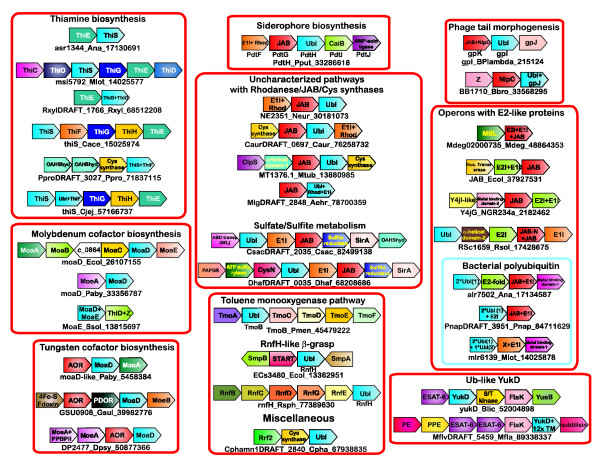
Gene neighborhoods of prokaryotic ThiS/MoaD-like ubiquitin domains and functionally associated proteins. Genes found in conserved neighborhoods are depicted as boxed arrows with the arrow head pointing from the 5' to the 3' direction. ThiS/MoaD-like proteins are shaded in blue. Other than in the classical ThiS and MoaD pathways, ThiS/MoaD/Ubiquitin-like proteins are labeled Ubl for ubquitin-like domain. The ThiS/MoaD-like proteins in each operon are identified in black lettering below the neighborhood by gene name, species abbreviation and gi number, demarcated by underscores. In the instances where ThiS/MoaD-like domains are absent, the gene neighborhoods are identified by the JAB domain containing protein. Alternative names of experimentally well characterized genes are shown below the boxed arrows for that gene. Boxed arrows with no colors represent poorly conserved proteins. Conserved neighborhoods are clustered according to major assemblages of gene neighborhood as described in the text. In Sulfolobus MoaD and MoaE are intriguingly linked to ThiD, but any possible role in thiamine biosynthesis remains unclear. Species abbreviations are listed in the legend to Figure 2. AOR, aldehyde ferredoxin oxidoreductase; Cys Synthase, cysteine synthase; PE, PE family of proteins; PPE, PPE family of proteins;Rhod, Rhodanese domain; Z, poorly characterized protein with an α + β domain with several conserved charged residues; X, β-strand rich globular domain; YueB, bacillus YueB-like membrane associated protein.